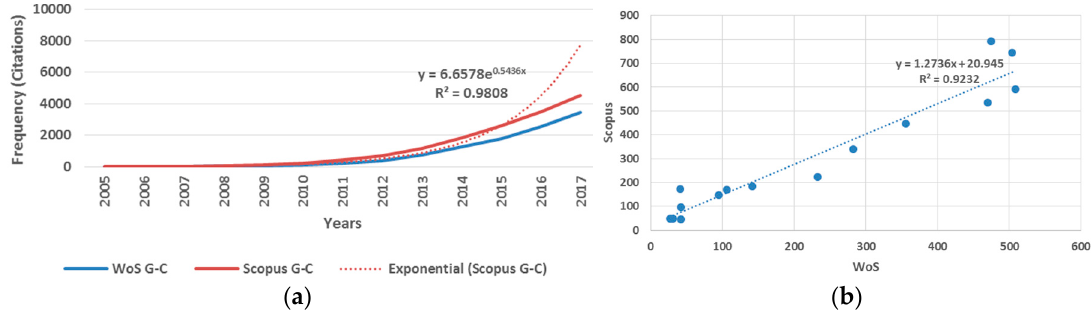
Figure 4. Growth ( a ) and Correlation (citations) ( b ). Source: Own elaboration.